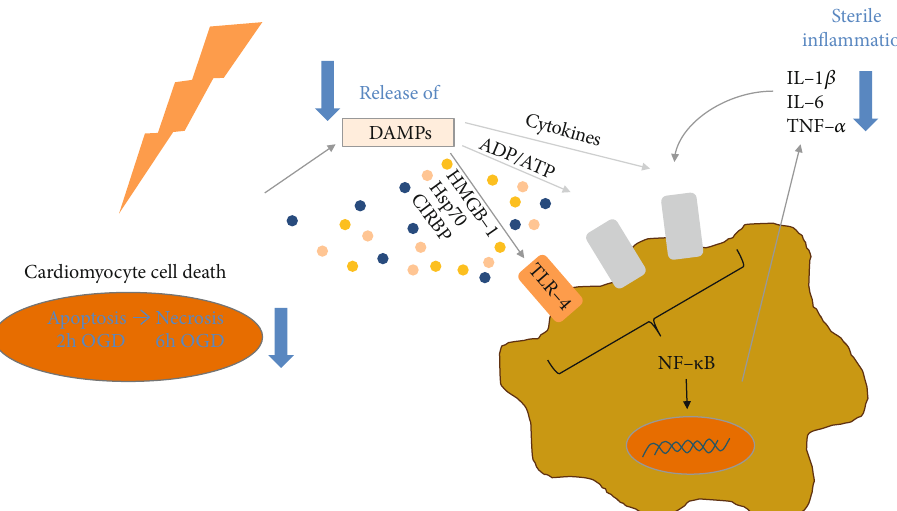
Figure 6: Synopsis of ischemia/reperfusion-induced DAMP release and the sterile in fl ammatory response in murine primary